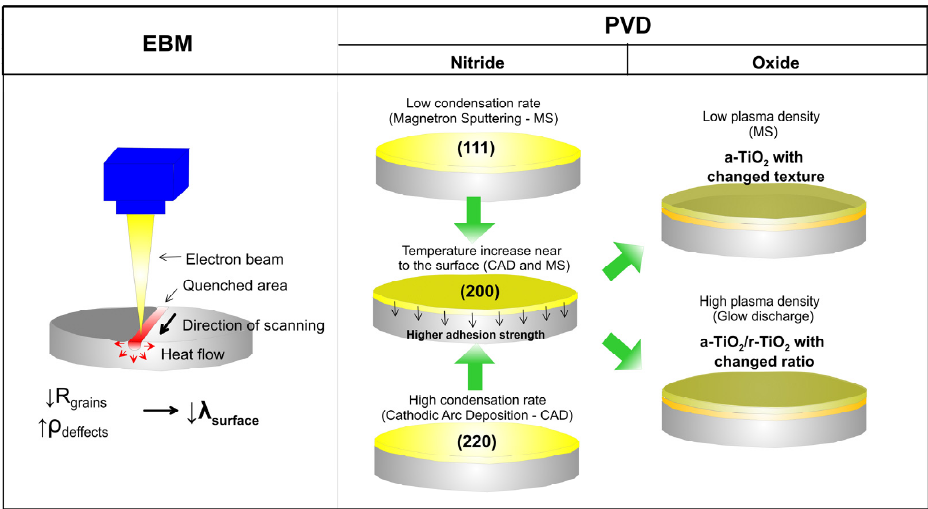
Figure 10. Schematic representation of the changes occurring after EBT of the metal surface and during deposition of the nitride/oxide coatings deposited by different methods.